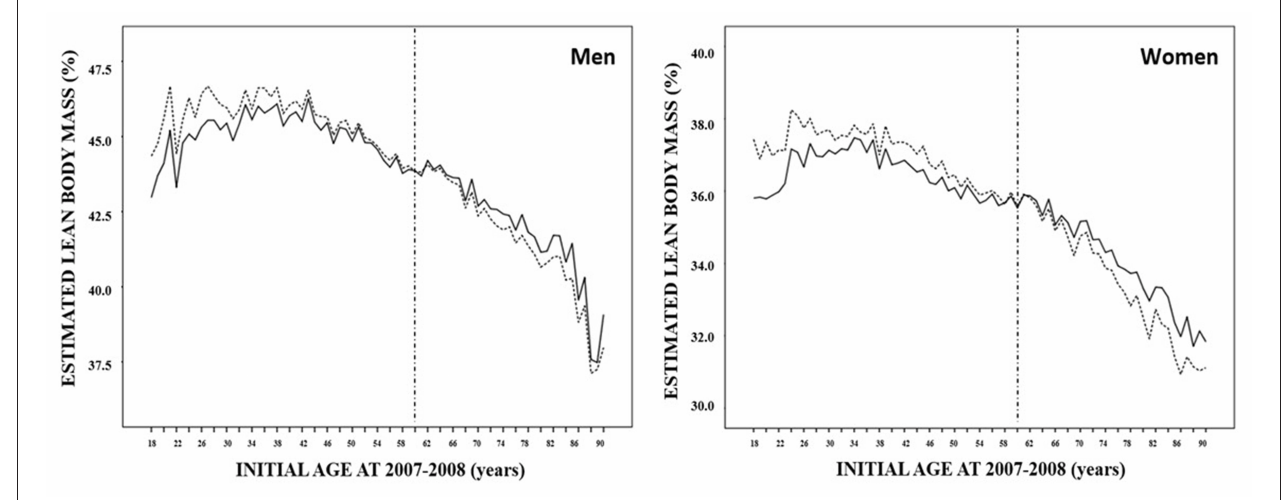
FIGURE 3 | Estimated mean lean body mass distribution of 32,050 subjects in the 2007–2008 (solid line) and 2017–2018 (dashed line) paired periods according to their age at the first evaluation and